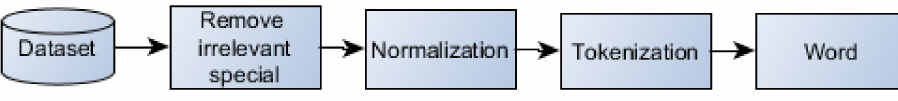
Figure 2. Dataset pre-processing steps.